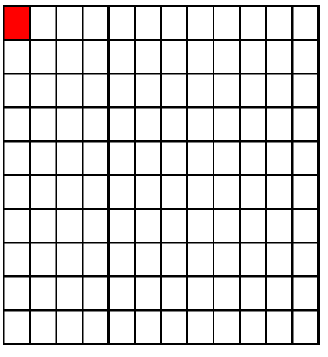
Figure 1. Grid where each square represents one student at a school. Table 8. Each student infects two